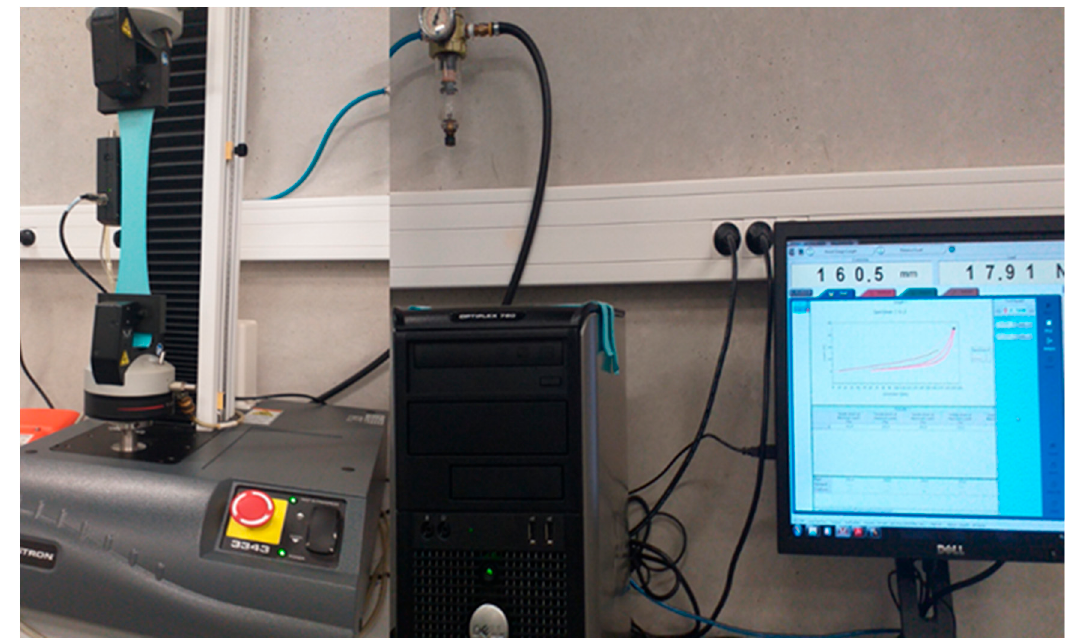
Figure 3. Strip tests for stretch-recovery measurement using an Instron 3334 Tensiometer.